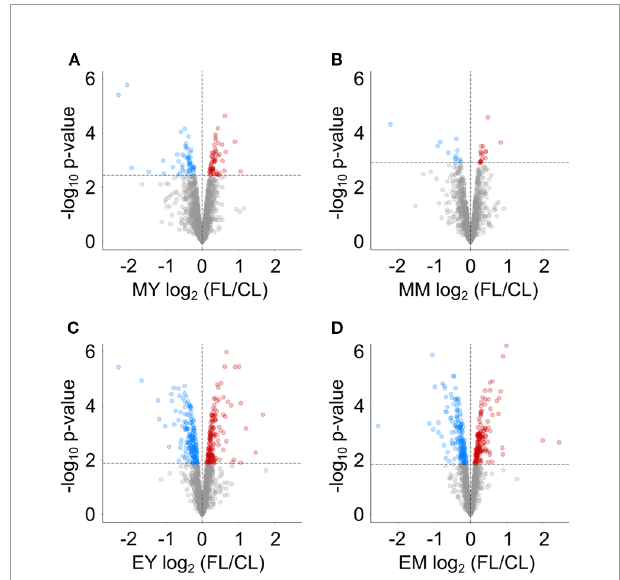
FIGURE 3 | Volcano plots indicating proteins with signi fi cant changes in abundance in FL compared to CL at (A) MY, (B) MM, (C) EY and (D) EM. Dashed lines indicate the chosen signi fi cance thresholds with a Benjamini- Hochberg corrected FDR < 0.05. Blue circles indicate depleted, red circles accumulating